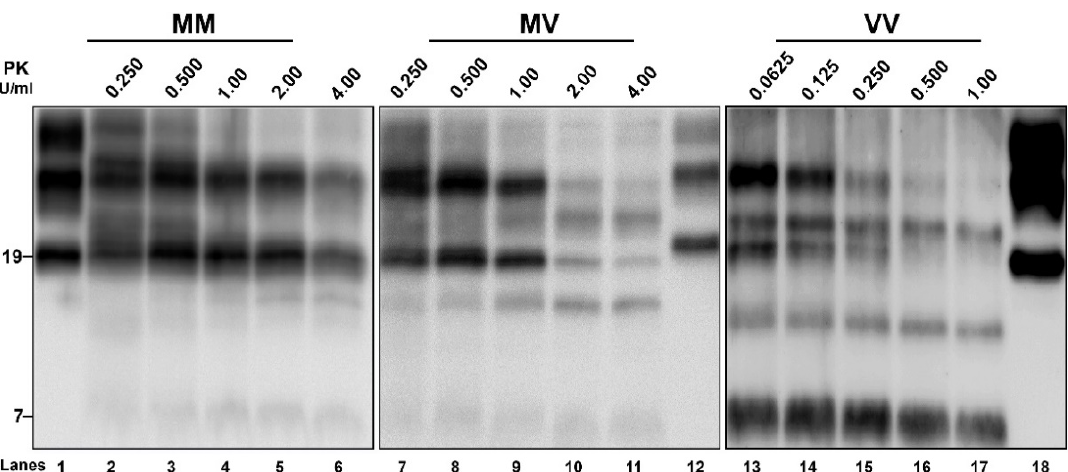
Figure 5. Analysis of PrP Sc protease ‐ resistance by PK titration. Brain homogenates from 129VV, 129MM, and 129MV cases were run after digestion with increasing amounts of PK to highlight the variable PK resistance of the PrP Sc fragments that are associated with the three codon 129 genotypes. In the 129VV case, we used lower PK concentrations than in 129MM and 129MV because of the higher sensitivity of PrP Sc to PK digestion, as demonstrated by the more significant signal loss in the three points of the curves with identical PK levels (i.e., 0.250 U/mL, 0.500 U/mL, 1.00 U/mL). Note the striking difference in the degree of PK resistance of the 19 kDa fragment among the three cases.